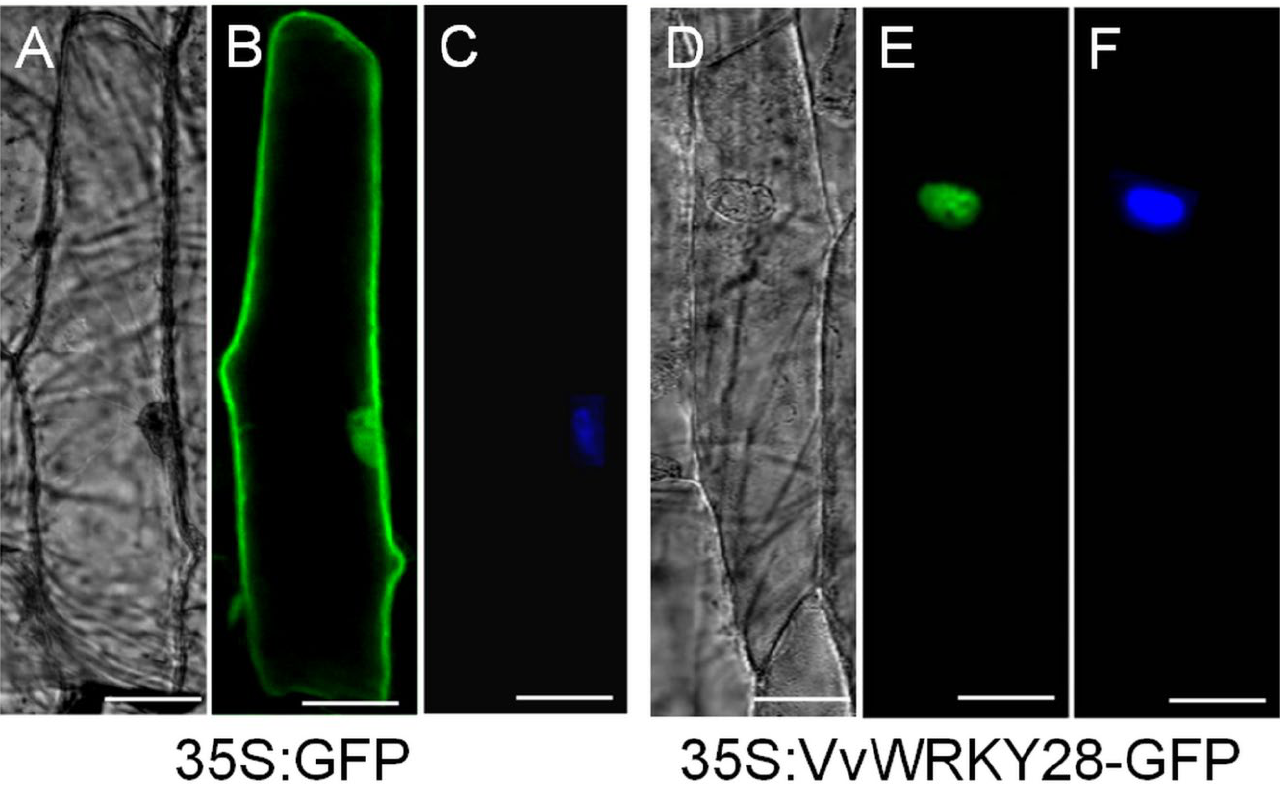
Figure 2. Subcellular localization of the VvWRKY28 protein: the transient expression of green fluorescent protein 35S: GFP and 35S: VvWRKY28-GFP fusion protein in onion epidermal cells was observed with a fluorescence microscope. ( A , D ) was the bright field effect, ( B , E ) was the dark field effect, and ( C , F ) was the result after DAPI staining. The scale corresponds to 5 µM.